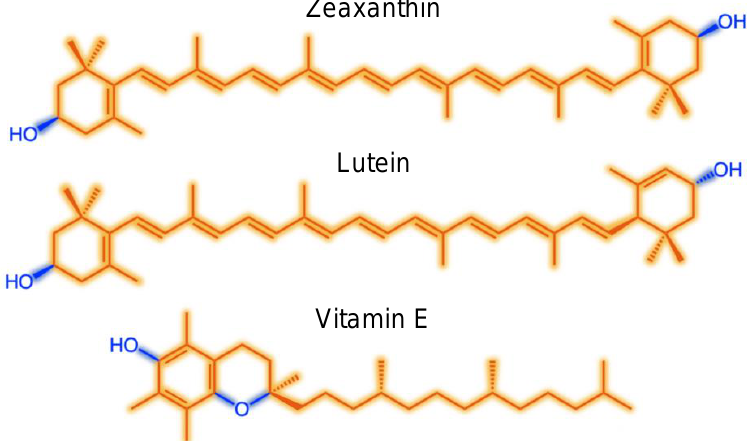
Figure 2. Chemical structures of the xanthophylls zeaxanthin (β,β-carotene-3,3′-diol) and lutein (β,ε-carotene-3,3′-diol) as well as vitamin E (a-tocopherol), with hydrophobic portions shown in orange and hydrophilic (oxygen-containing) portions in blue. For further detail on structure, biosynthesis, and food sources of these xanthophyll, see [6].